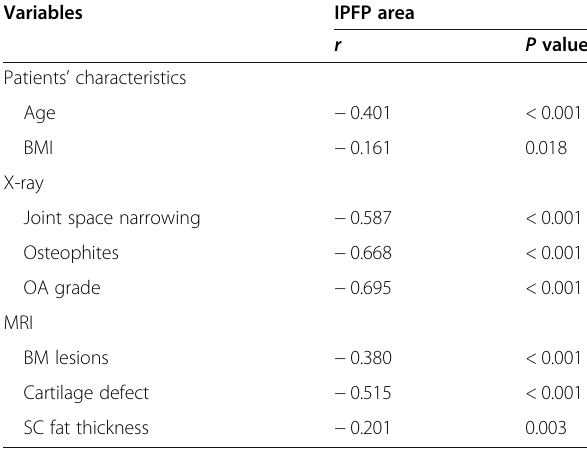
Table 4 Correlation between the IPFP area and both patient and disease characteristics Variables